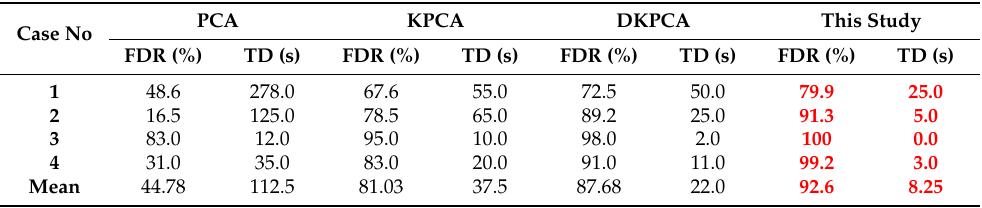
Table 4. Comparison with PCA, KPCA, DKPCA in FDR and TD.